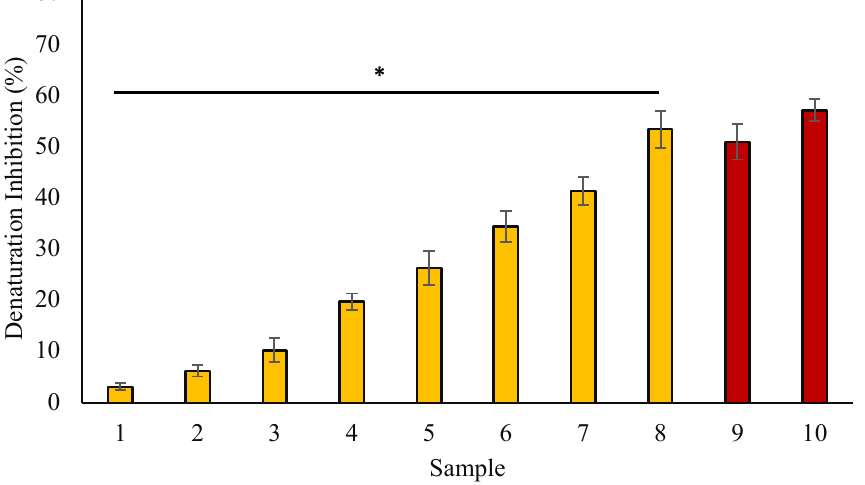
Figure 3. Percentage inhibition of heat-induced denaturation of albumin. Samples 1 to 8 (yellow bar) correspond to various concentrations of extract (50, 75, 100, 200, 300, 400, 500, and 600 µg/mL). Samples 9 and 10 (red bar) correspond to 100 and 200 µg/mL concentrations of ibuprofen. The data are shown as means ± standard error of the means (n = 3, p < 0.05). The statistical differences are represented with an asterisk (*) for myrrh denoting significance at p < 0.05 in comparison with the reference sample.